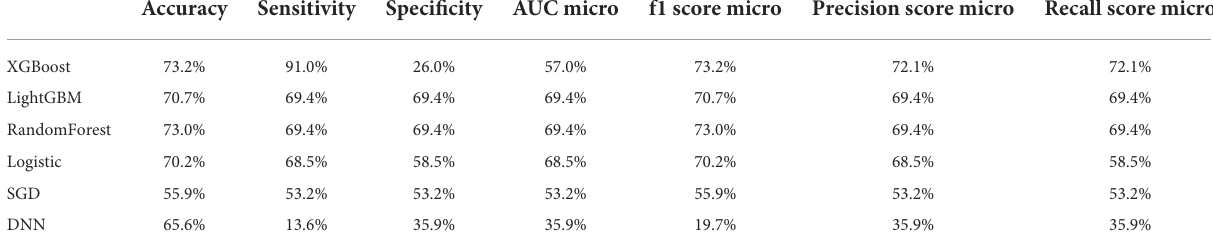
TABLE 3 Accuracy, sensitivity, specificity, AUC and other predictive value of all prediction